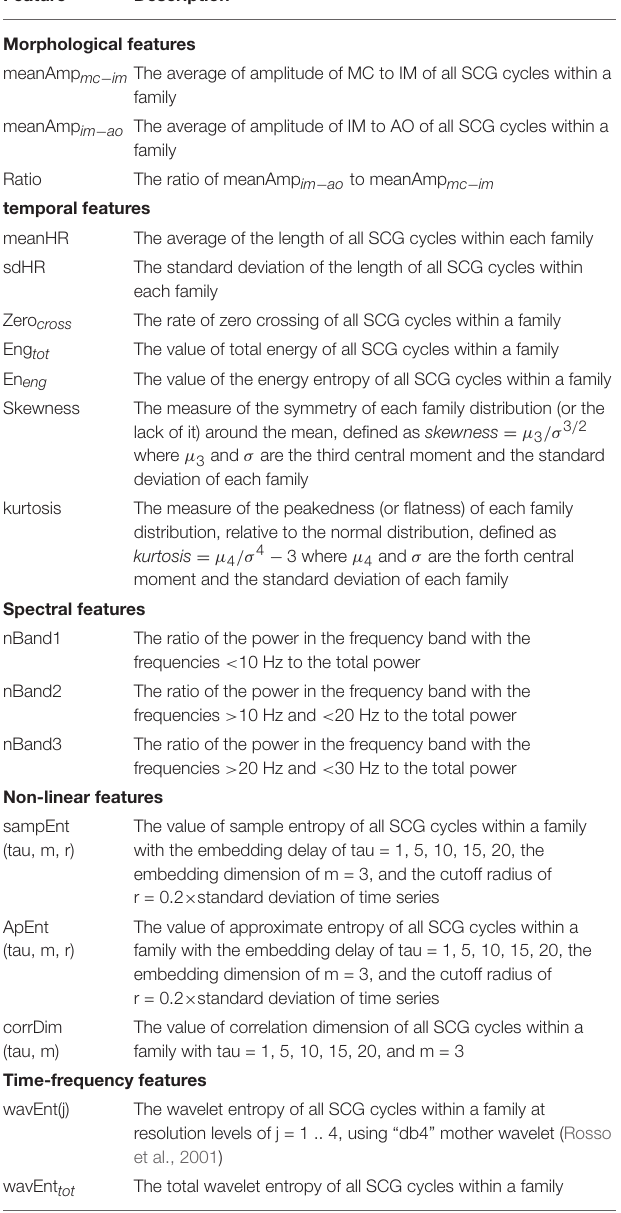
TABLE 1 | Description of the features extracted from the family of SCG